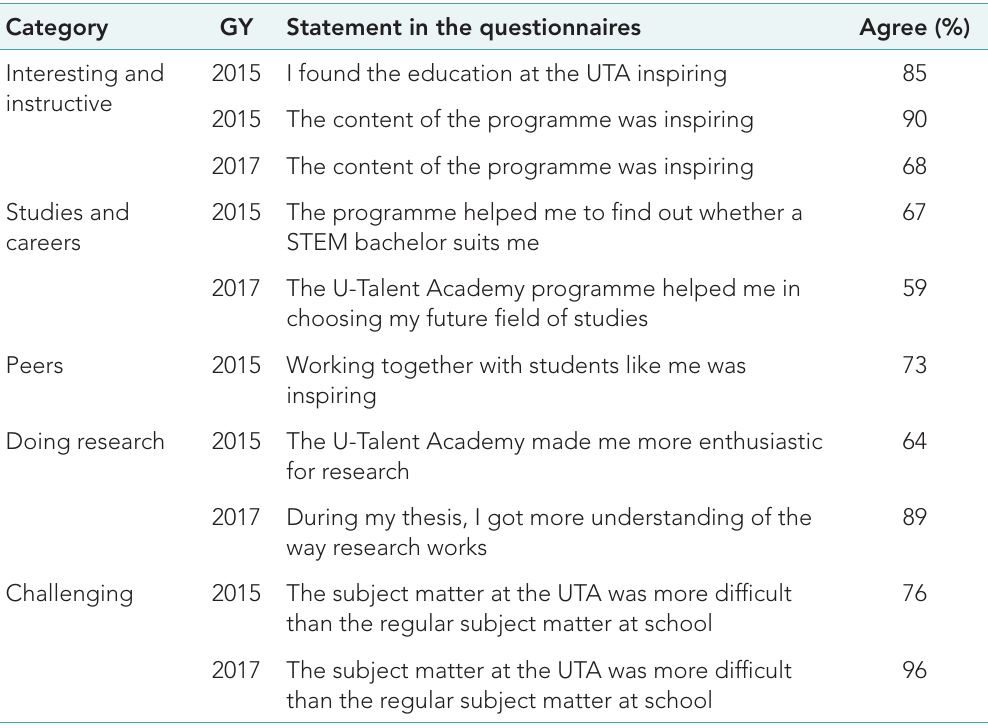
Table 6: Answers to closed questions in the questionnaires at the end of graduation years (GY) 2015 (n=96) and 2017 (n=79) – the percentages of students that